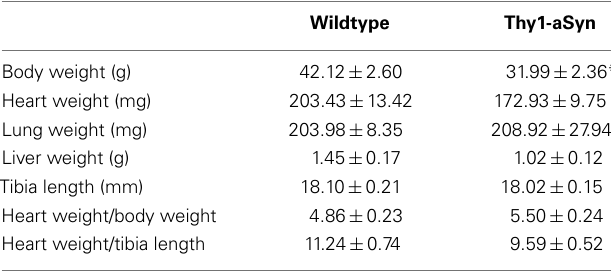
Table 1 | Morphometry parameters inThy1-aSyn and wildtype mice at